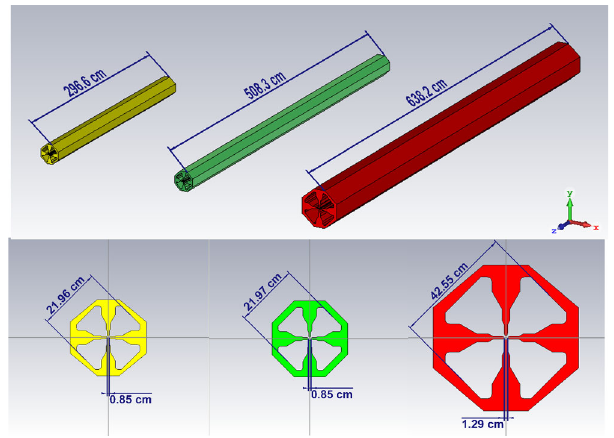
FIG. 22. Comparison of 3D models for the conceptual design of SC-RFQ for BNCT. Yellow: 2.5 MeV proton, blue: 5 MeV proton, red: 5 MeV